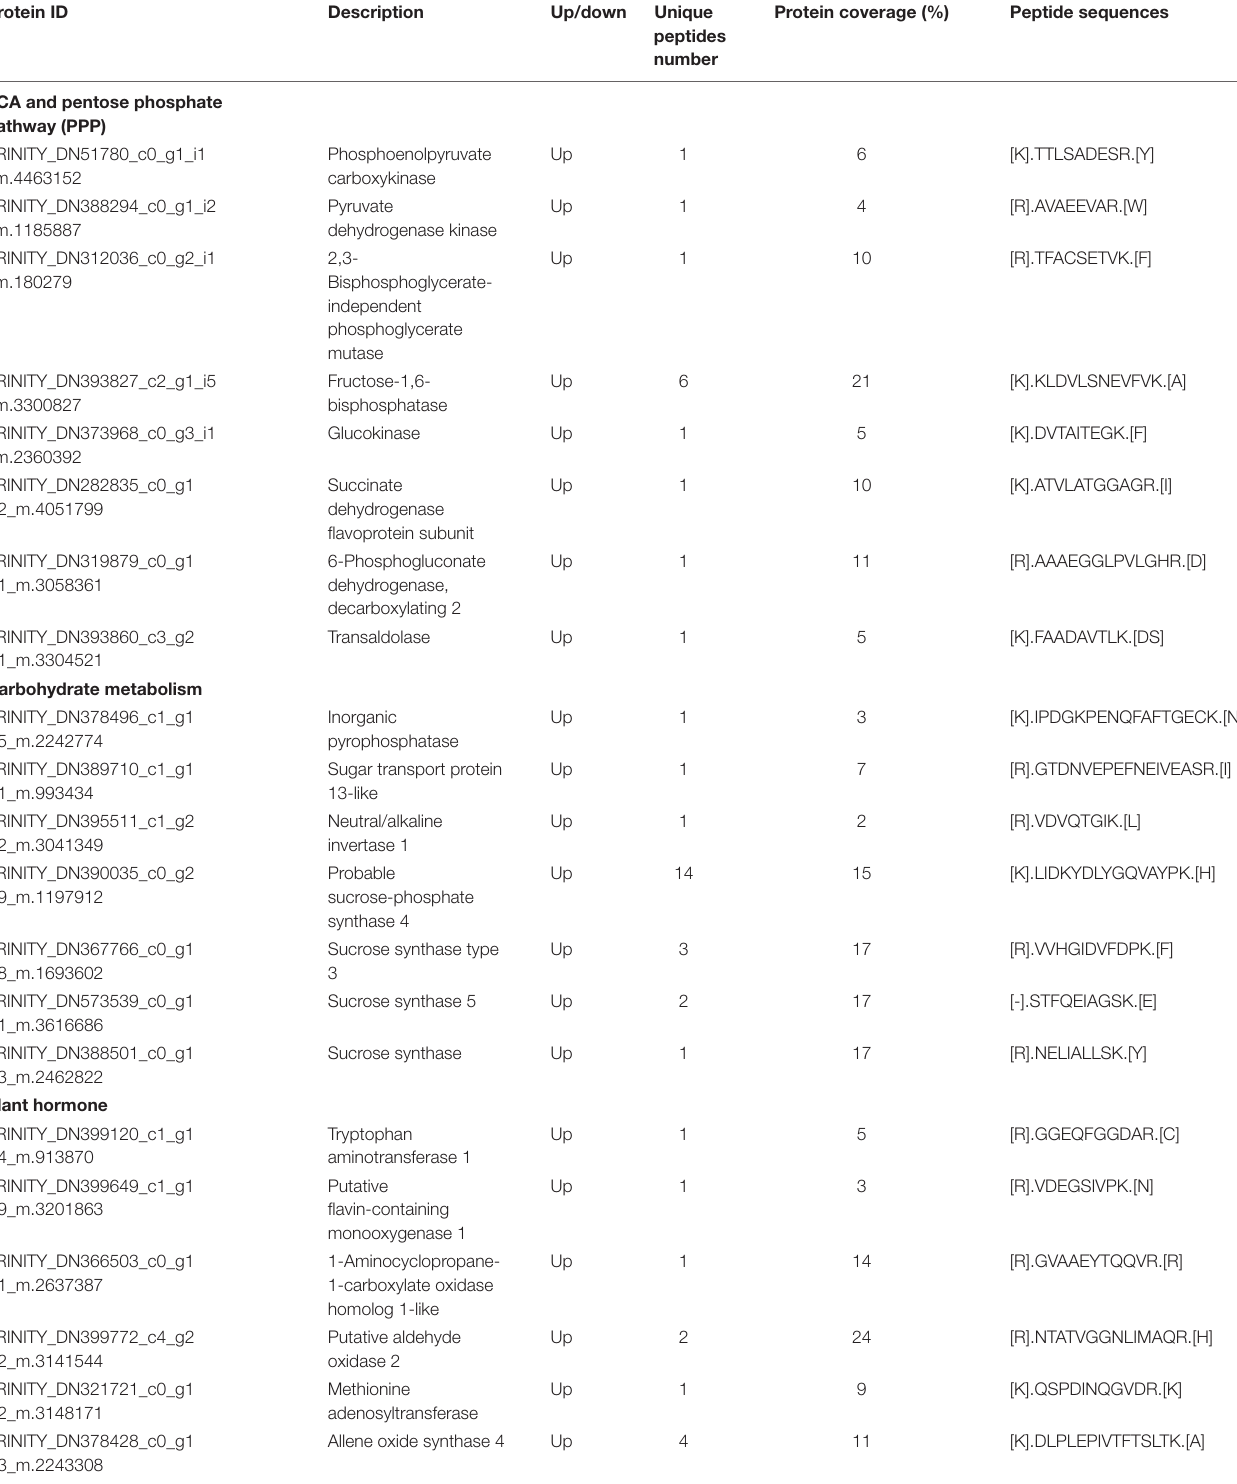
TABLE 1 | Some differentially expressed proteins related to alkali tolerance in roots at AS vs. CK. Protein ID Description Up/down Unique